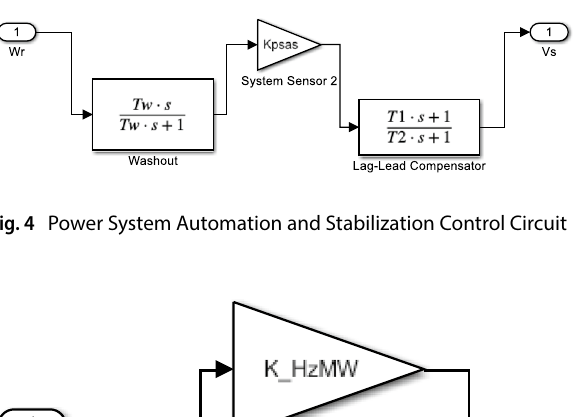
Fig. 6 Power–Frequency Measurement Module